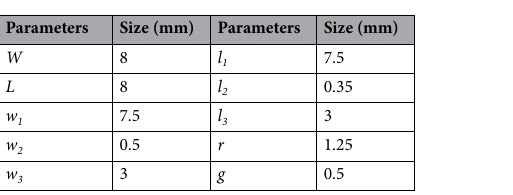
Figure 1. SES-MAA unit cell ( a ) top view with various dimension ( b ) back view with full copper.